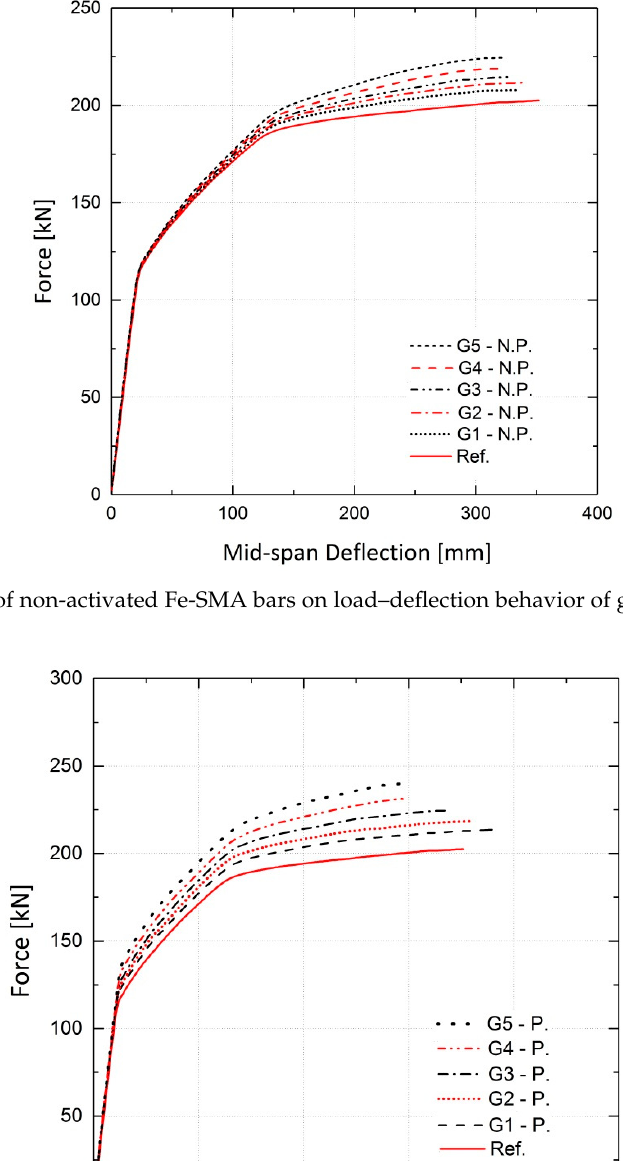
Figure 28. Effect of activated and non-activated Fe-SMA bars on load–deflection behavior of G5.